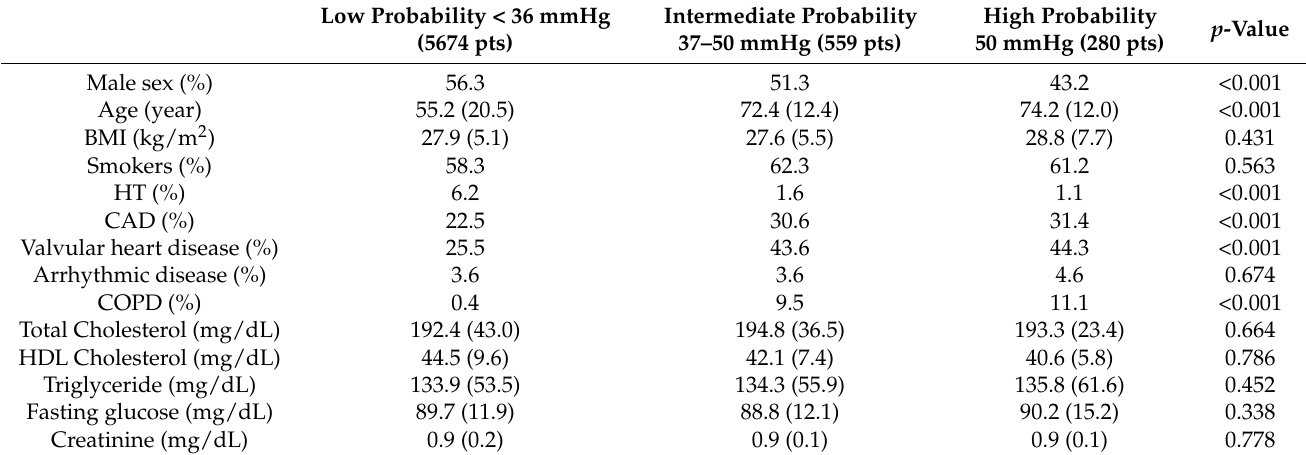
Figure 2. Mean PASP in the study population, classified into five groups, using criteria of the ESC classification. Group 1: Idiopathic PH; group 2: PH in association with left heart disease; group 3: PH related to hypoxic lung disease; group 4: PH due to chronic thrombo-embolic disease (CTEPH); group 5: Miscellaneous. The second group is the most common in our study. A significant difference of mean PASP by group ( p < 0.001) is calculated. No significant difference between men and women ( p = 0.132). Among the patients with higher values of PASP, females with comorbidities ( p = 0.001) and evidence of systolic and diastolic left and/or right ventricular dysfunction (both p = 0.001) were more prevalent. Data are shown in Table 2. Table 2. Population distribution by PH